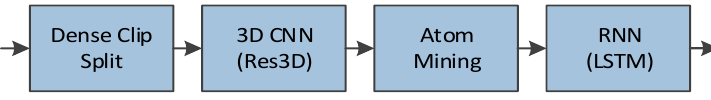
Figure 2. The illustration of a stream in our proposed method.